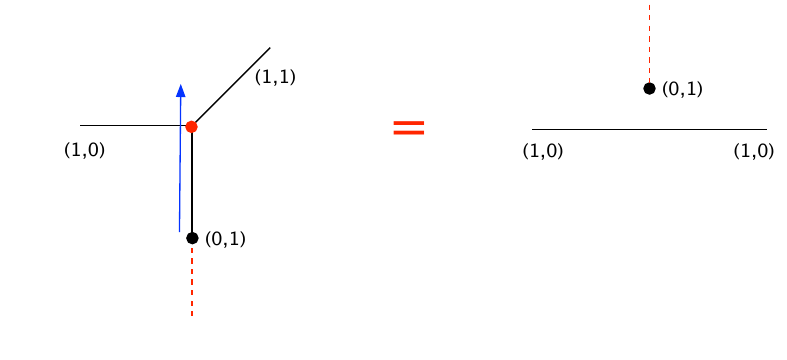
Figure 19 . A simple trivial junction.